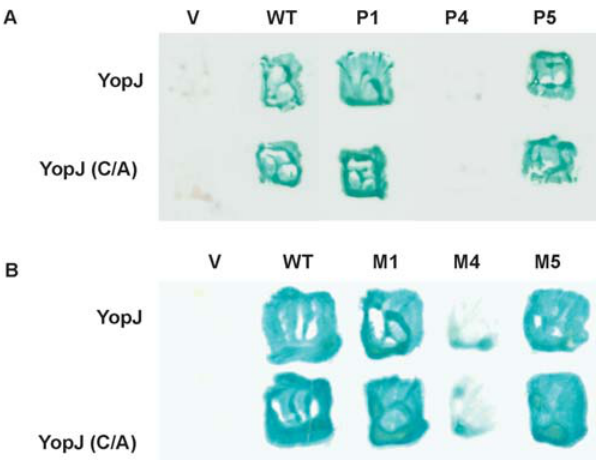
Figure 3. Interaction between YopJ and Pbs2 or MKK1 mutants. (A) Yeast two-hybrid assay of the interaction between YopJ or YopJ(C172A) mutant and Pbs2 wild type or Pbs2 mutants from the screening. (B) Yeast two-hybrid assay of the interaction between YopJ or YopJ(C172A) mutant and corresponding MKK1 mutants.